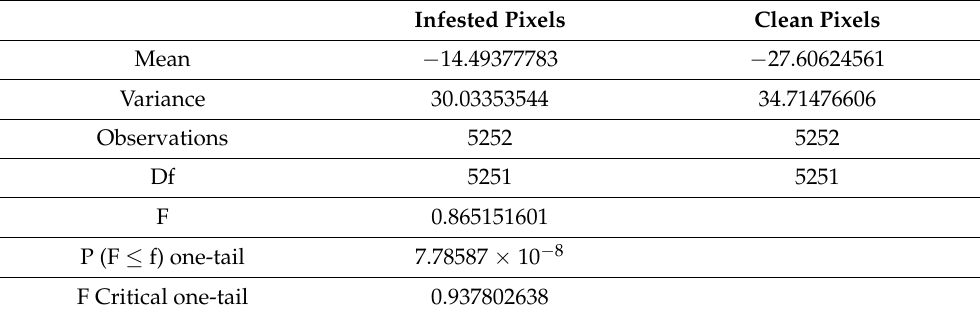
Table 1. F-test for clean (2019-11-02) and infested (2020-01-19) pixels.